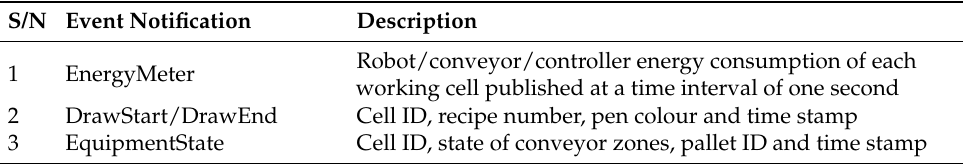
Table 1. Event notification from